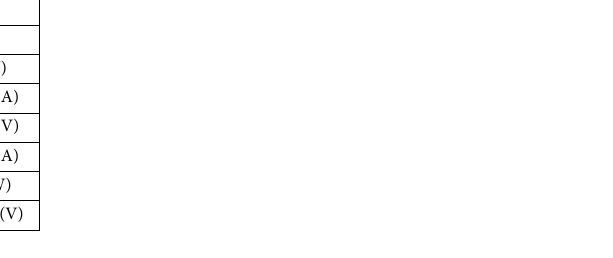
Table 4. PV panel specifications.